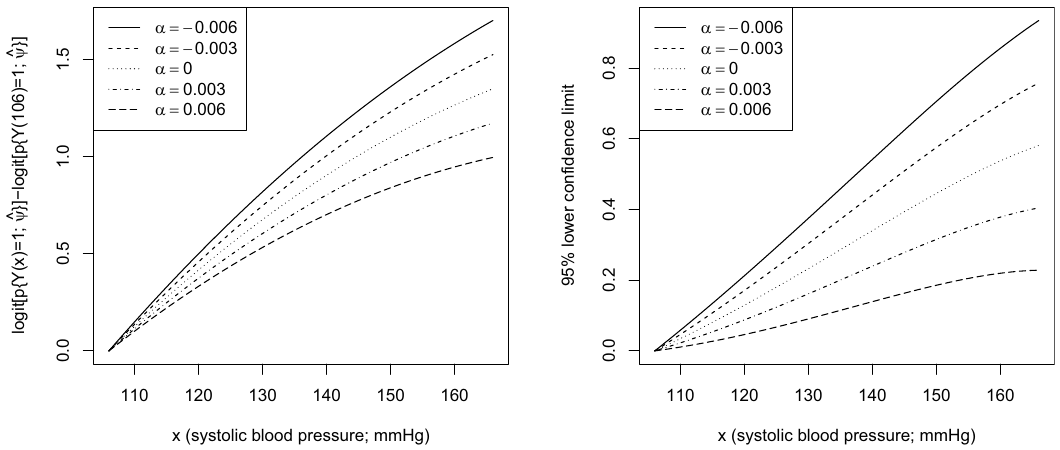
Figure 4: The estimated marginal causal log odds ratio ( left panel ) for systolic blood pressure and CHD and its lower pointwise 95% con fi dence limit ( right panel ) , as functions of systolic blood pressure x , for selected values of the sensitivity parameter α . The log odds ratio uses systolic blood pressure 106 mmHg as reference level, and is estimated under a quadratic causal